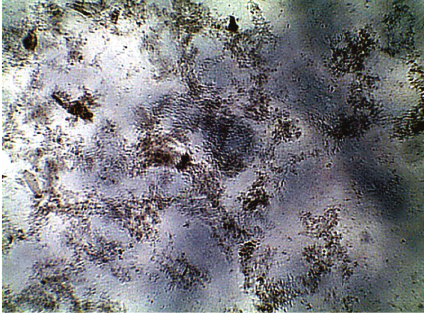
Figure 2: Agglutination reaction of BGs prepared from S. typhimurium ATCC 14028 using experiment number 1 as in Table 1.